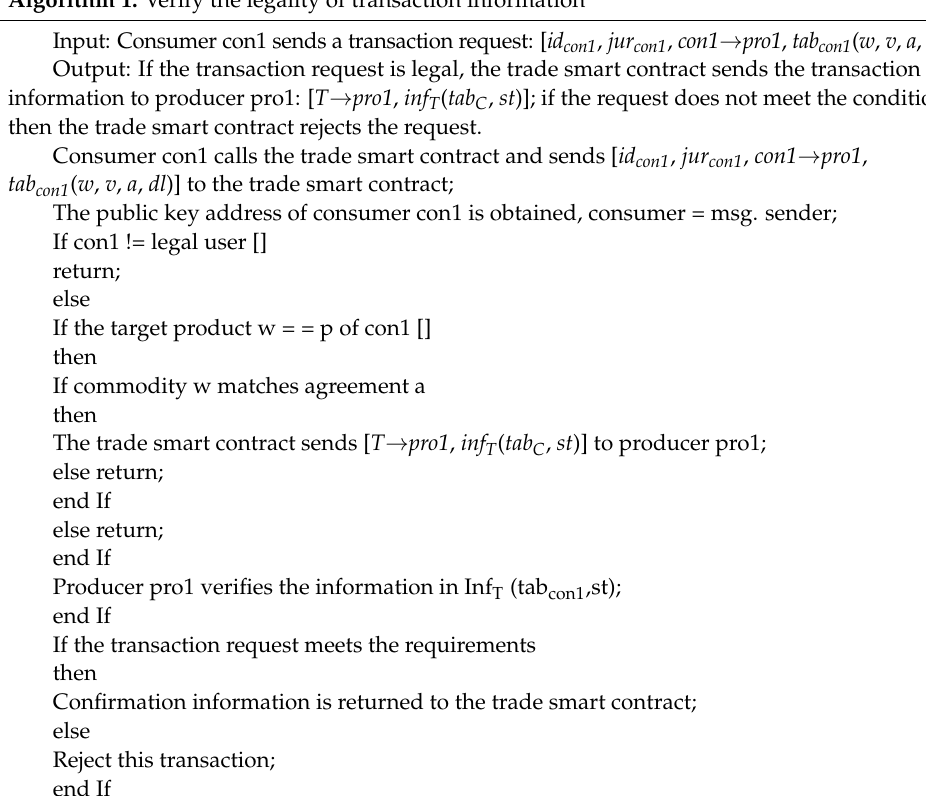
Algorithm 1. Verify the legality of transaction